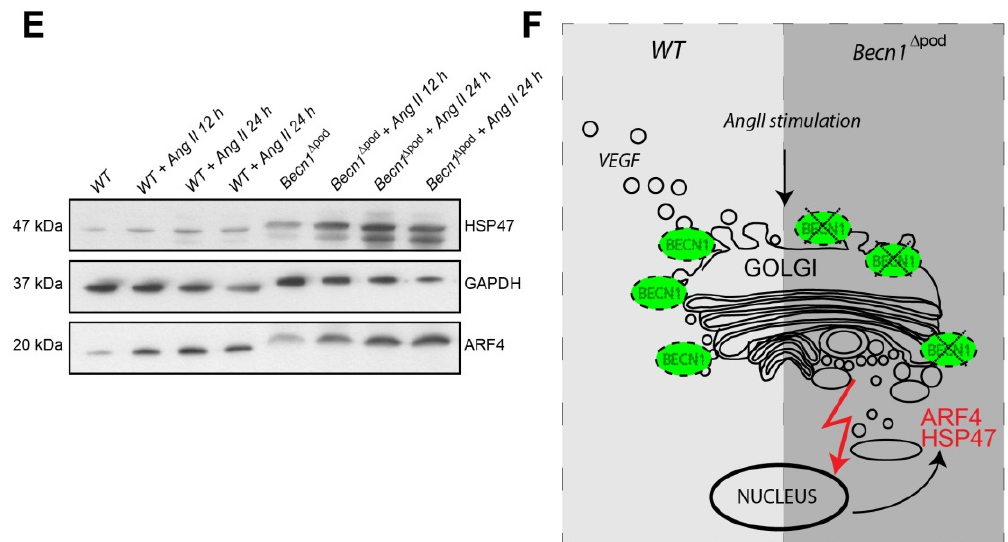
Figure 7. Beclin1 is indispensable for glomerular endothelial integrity and VEGF secretion. ( A ) Transmission electron microscopy (TEM) images of kidney sections obtained from 4-week-old and 8-week-old WT and Becn1 flox/flox × h Nphs2 - Cre mice; ( B ) Western blot showing the abundance of BECLIN1, VEGF and ACTIN in lysates obtained from immortalized WT and Becn1 -deficient murine podocytes; ( C ) Relative levels of VEGF in the supernatant of serum-starved WT and Becn1 -deficient podocytes; ( D ) Relative levels of VEGF in the supernatant of serum-starved WT and Becn1 -deficient podocytes after angiotensin II (AngII) stimulation (10 − 6 M at the time indicated); ( E ) Western blot showing the abundance of HSP47, ARF4 and GAPDH in lysates obtained from immortalized WT and Becn1 -deficient murine podocytes with and without AngII stimulation (10 − 6 M); ( F ) Schematic showing the proposed role of BECLIN1 in orchestrating vesicle formation for anterograde Golgi trafficking and VEGF secretion.